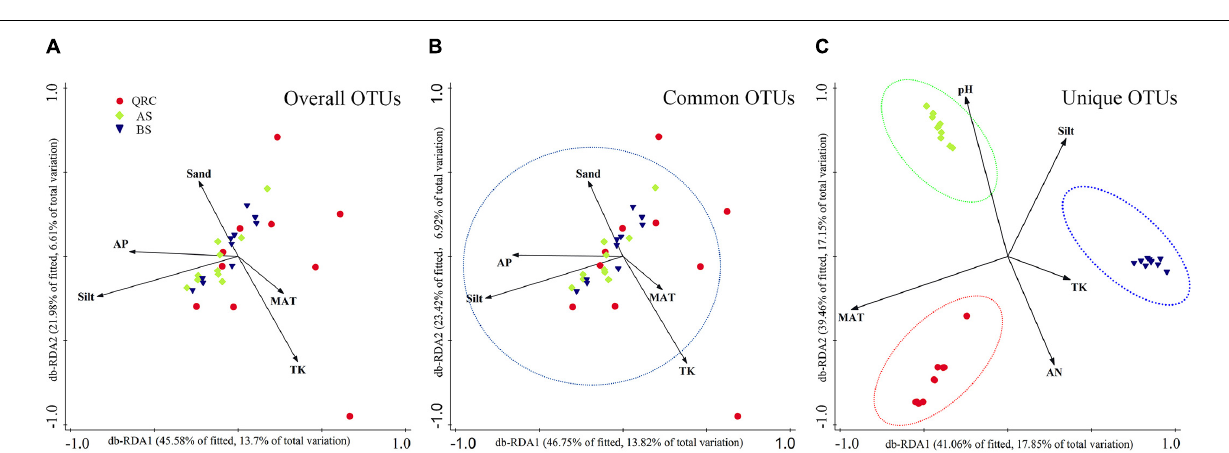
FIGURE 5 | Distance based redundancy analysis (db-RDA) showing the relationships between overall (A) , common (B), and unique (C) fungal nirK -containing communities and environmental factors. db-RDA axes describe the percentage of the fitted or total variation explained by each axis while being constrained to account for group differences. Red circle- QRC, Green diamond- AS, Blue down triangle- BS. AS, alluvial soils; BS, black soils; QRC, quaternary red clay soils; TK, total potassium; AN, available nitrogen; AP, available phosphorus; MAT, mean annual